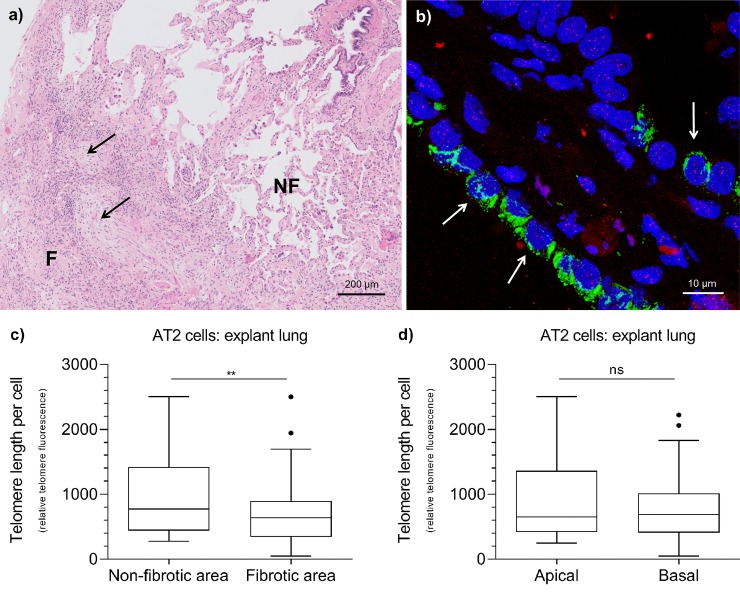
AT2 cell telomere length in IPF explant lung tissue measured by FISH.(a) Hematoxylin and Eosin (H&E) staining representing non-fibrotic (NF) and fibrotic (F) areas of a typical IPF lung biopsy. Black arrows indicate fibroblast foci. (b) Example of a combined fluorescent image of AT2 cells (white arrows) in a fibrotic area of IPF lung tissue. DNA in nucleus is displayed in blue (DAPI), proSP-C in green and telomeres in red (dots). (c) Within a tissue specimen, telomere length in AT2 cells was significantly longer in non-fibrotic areas than in fibrotic areas. (n = 3; Mann-Whitney test: ** < 0.01). (d) No difference in AT2 cell telomere length was observed between apical and basal lung tissue. Boxes represent data between 1st and 3rd quartile and whiskers extend to the highest and lowest values of expression that are not considered outliers.